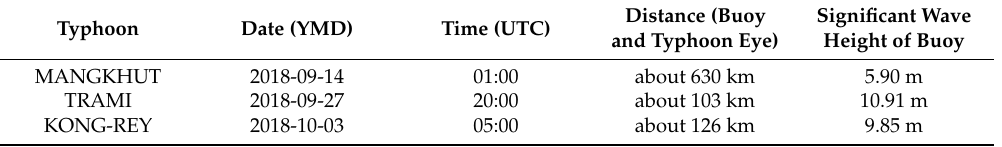
Table 3. Maximums of significant wave height from the SBF7-1A GPS wave buoy in three typhoons. Table 4. Comparison of significant wave heights between the SBF7-1A GPS wave buoy and remote sensing